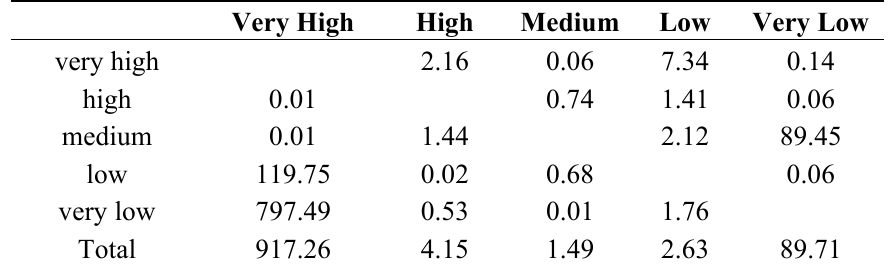
Table 9. Squared deviances estimated based on observed and expected frequencies—Vea study area.